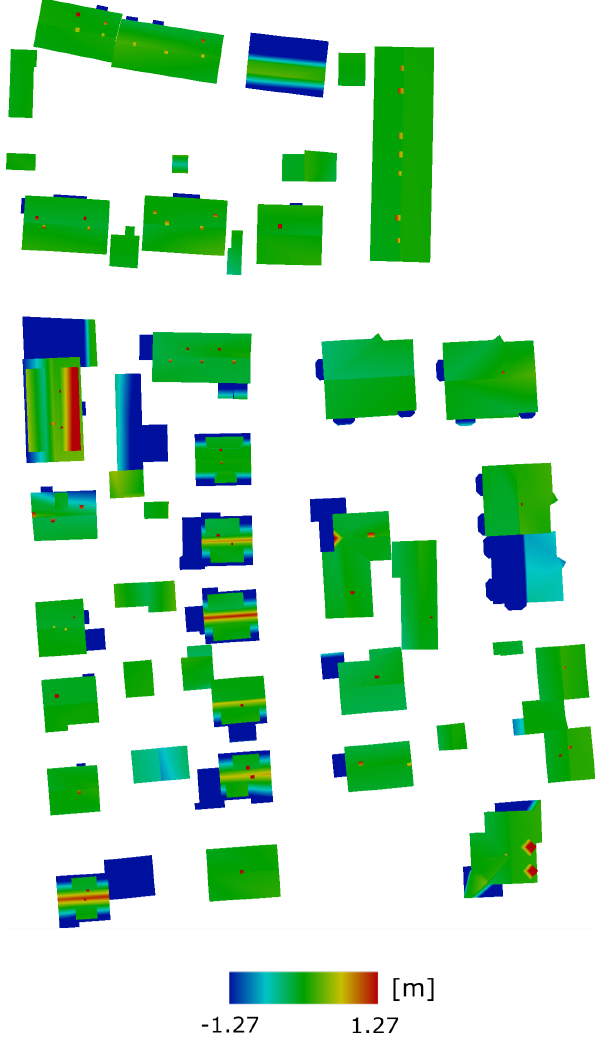
Figure 11. Height difference comparison of the output of the proposed algorithm with the ground truth data of the ISPRS